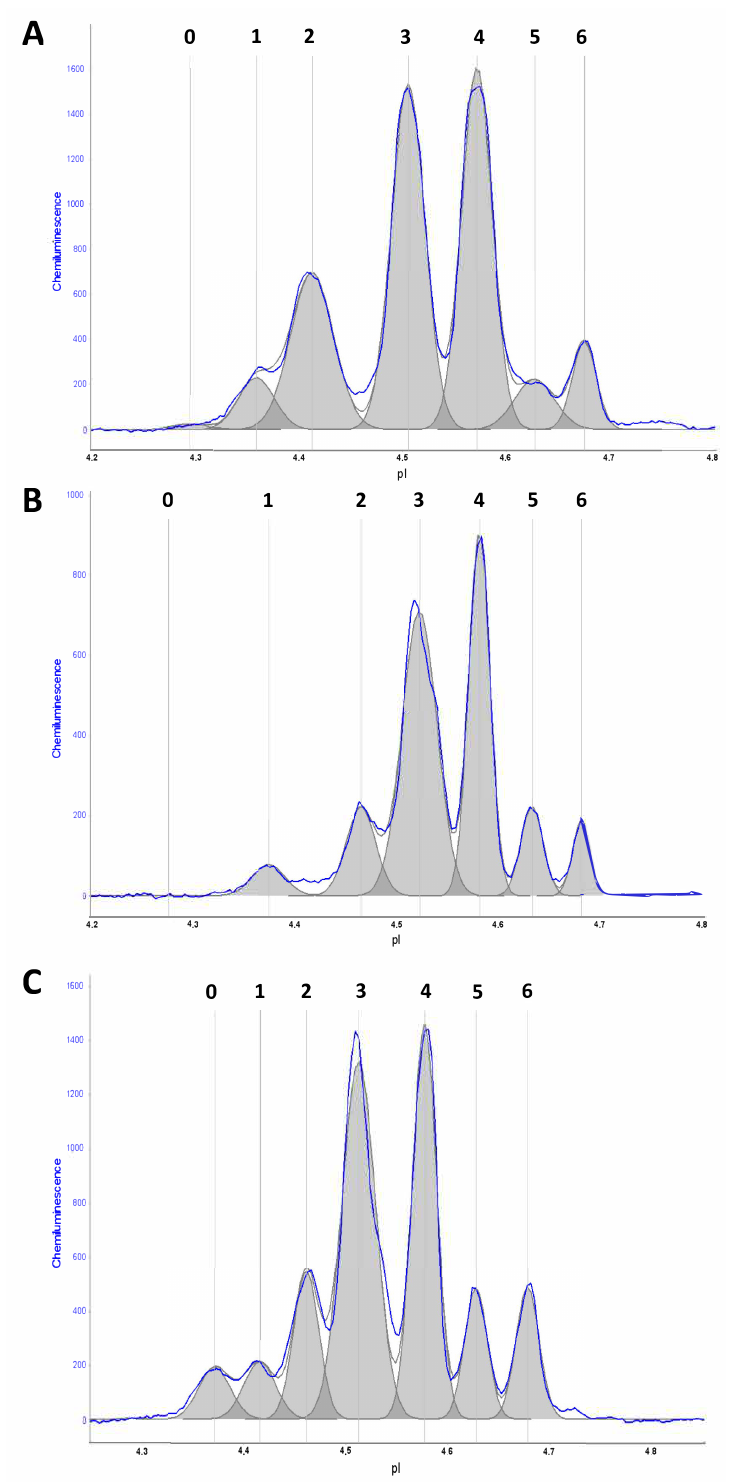
Figure 1. Typical CIEF electropherograms of serpinA1 isoforms. Exemplary CIEF electropherograms of ( A ) control subjects (six distinct peaks in the pH range of 4.3–4.7), ( B ) patients with Alzheimer’s disease with dementia (AD-dem) (with a relative decrease in isoform 2 and an increase in peak 4) and ( C ) patients with Parkinson’s disease with dementia (PDD). The grey color indicates the area under each peak. Signal intensity is reported in chemiluminescence units (CUs). pI: isoelectric point; exposure time: 120